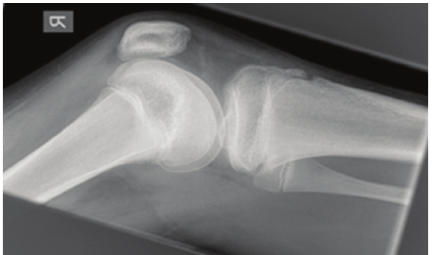
Figure 4: Lateral radiograph of the right knee taken seven weeks after